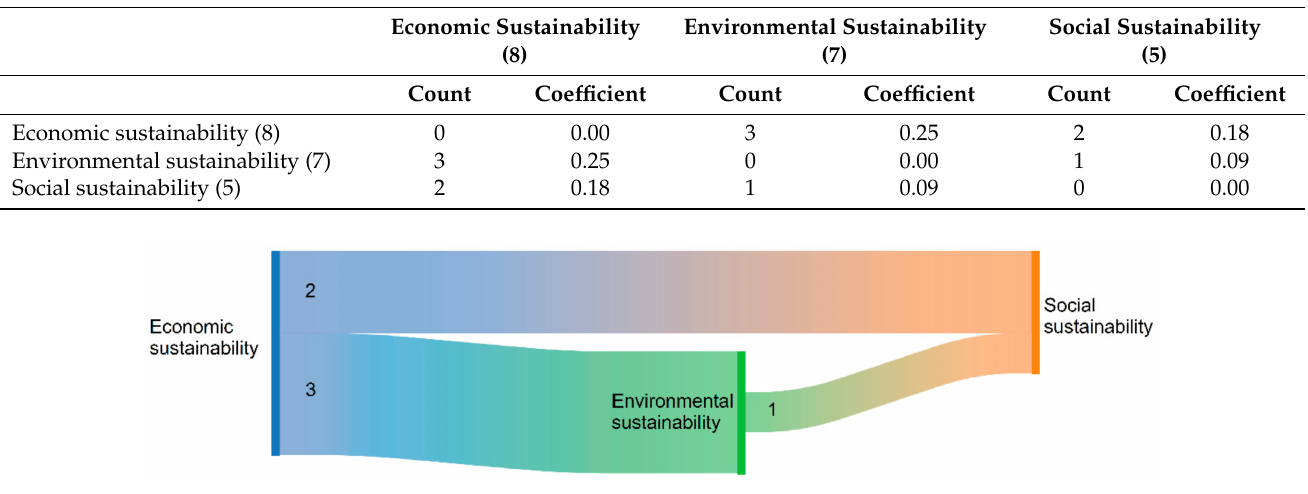
Figure 5. Diagram of relationships between the contents considered as limitations of the sustainability category, from the review of scientific articles on multi-storey timber